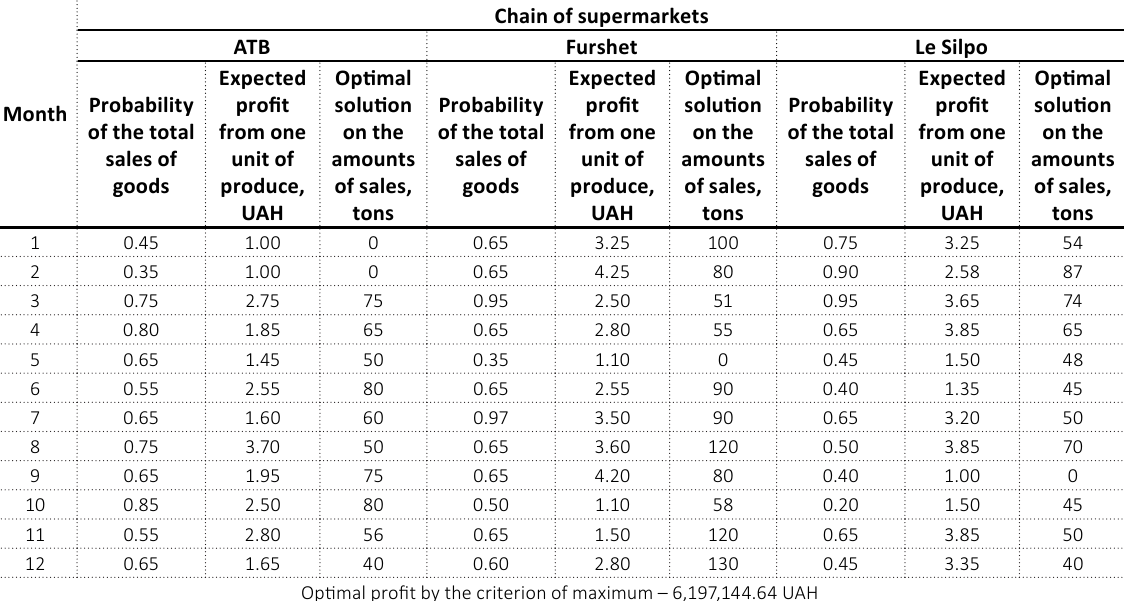
Table 4. The project of the logistical decision on distributing the vegetable produce by sales channels in different months of 2019 (expected annual average loading of the production capacities)